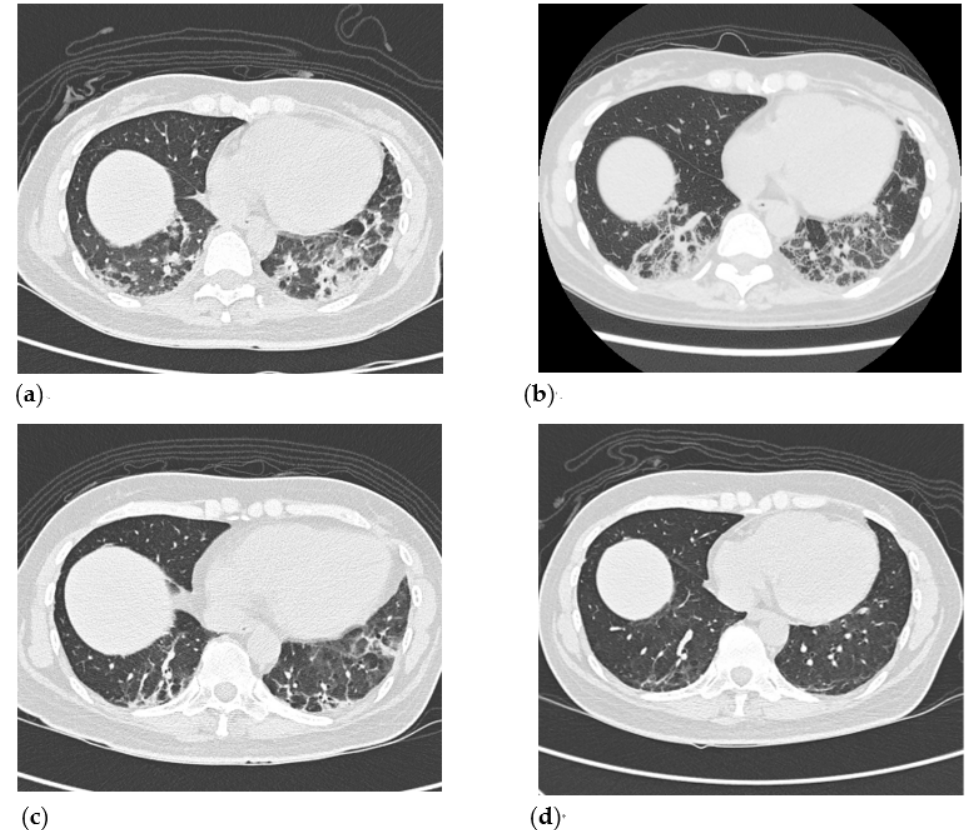
Figure 3. Serial HRCT follow-up (axial view) on week 4, week 8, week 20, and week 42. ( a ). HRCT arranged on week 4 showed increased peribronchial and subpleural consolidation and ground glass opacities (GGO) over the left lower lung. ( b ). HRCT on week 8 revealed partial resolution of subpleural consolidation over the left lower lobe. However, interlobular septal thickening and a peri-lobular pattern at the subpleural area of bilateral lower lungs were noted on the HRCT image. ( c ). HRCT on week 20 demonstrated obvious resolution of subpleural consolidation and GGO over bilateral lower lung fields. ( d ) HRCT on week 42 disclosed regressive change of GGO lesion in bilateral lungs, and only a small fibrotic band existed in bilateral lower lung fields.